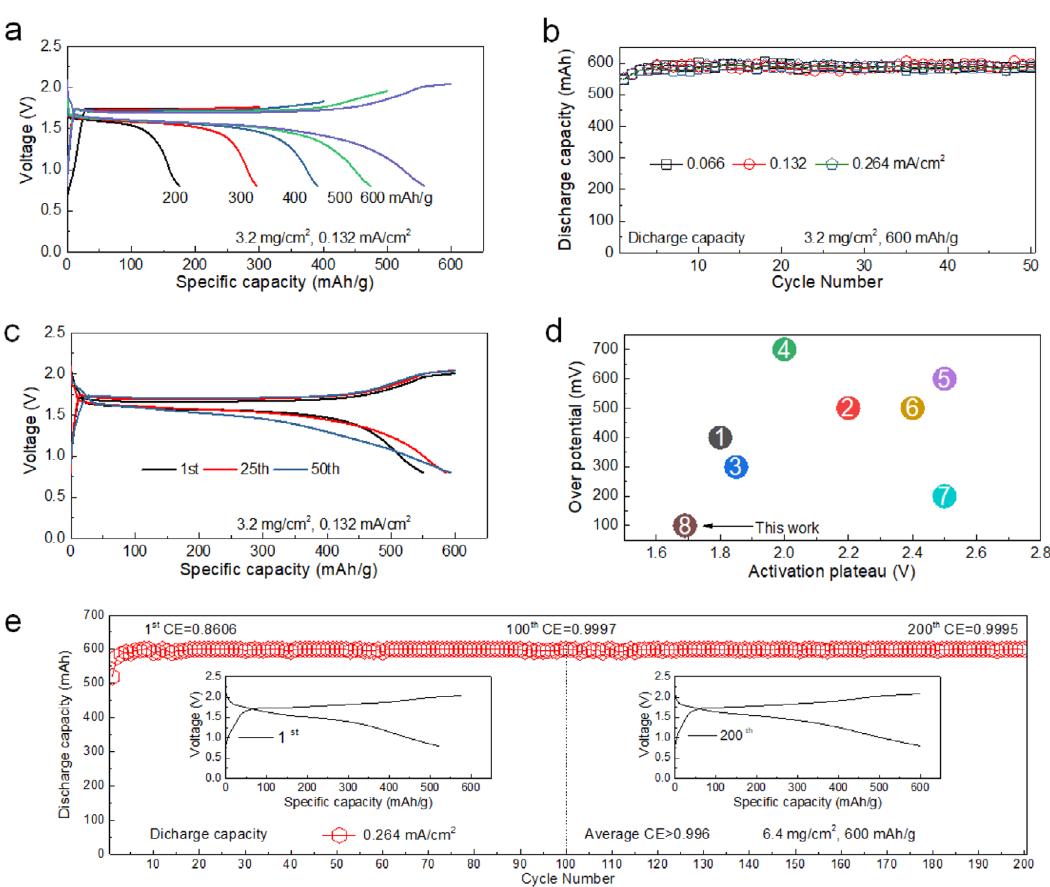
Fig. 5 Electrochemical energy storage performances of a In-Li | m LPSC | m Li 2 S(LiI) cell. a Charge and discharge curves of the In-Li | m LPSC | m Li 2 S(LiI) cell cycled incrementally from 200 to 600 mAh/g at a 0.132 mA/cm 2 current density; b Discharged capacity of the In-Li | m LPSC | m Li 2 S(LiI) cell cycled to 600 mAh/g at 0.066, 0.132 and 0.264 mA/cm 2 respectively; c 1st, 25th, and 50th charge and discharge curves of the In-Li | m LPSC | m Li 2 S(LiI) cell cycled at 0.132 mA/cm 2 current density; d Overpotential versus average activation voltage plateau comparing results from literature as listed in Supplementary Table 1 with the present work; e Discharge capacity of the In-Li | m LPSC | m Li 2 S(LiI) cell cycled to 600 mAh/g at 0.264 mA/cm 2 current density up to 200 cycles. The discharged capacity divided by 600 is identical to the Coulombic ef fi ciency, because the cells were charged to a fi xed capacity of 600